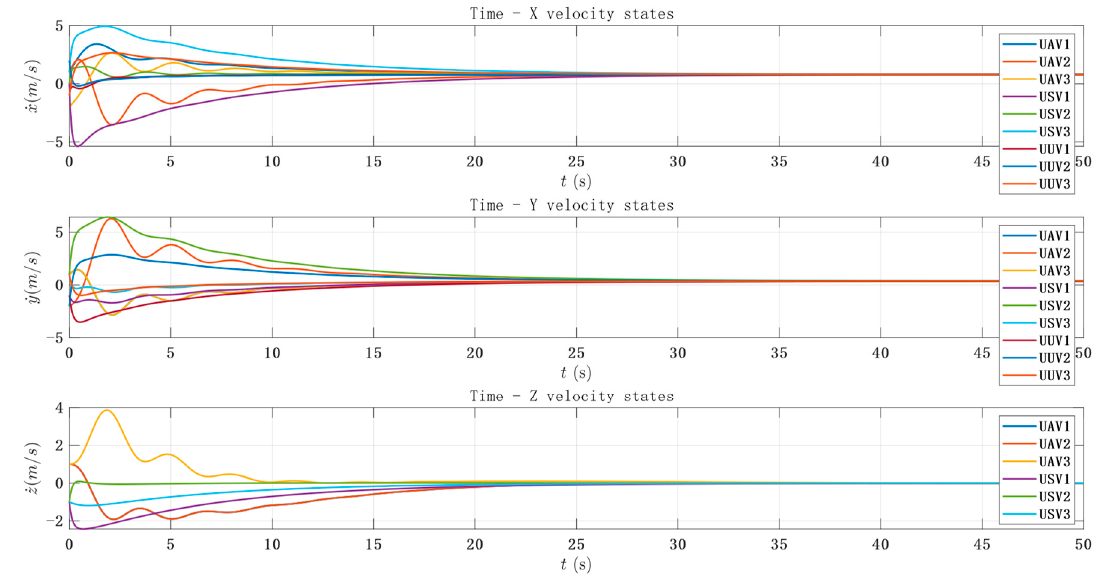
Figure 8. Velocity state with dynamic formation control.